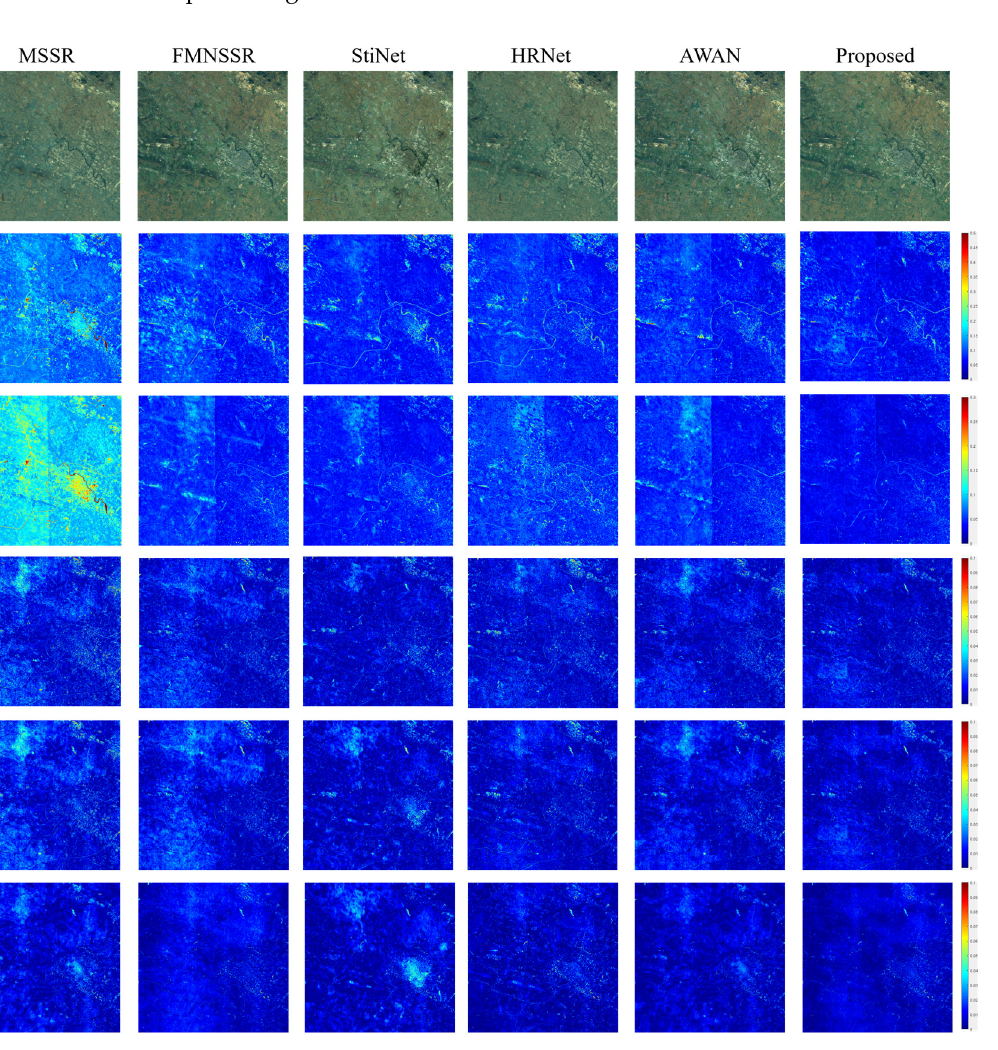
Table 4. Quality assessment comparison on GF5 data.